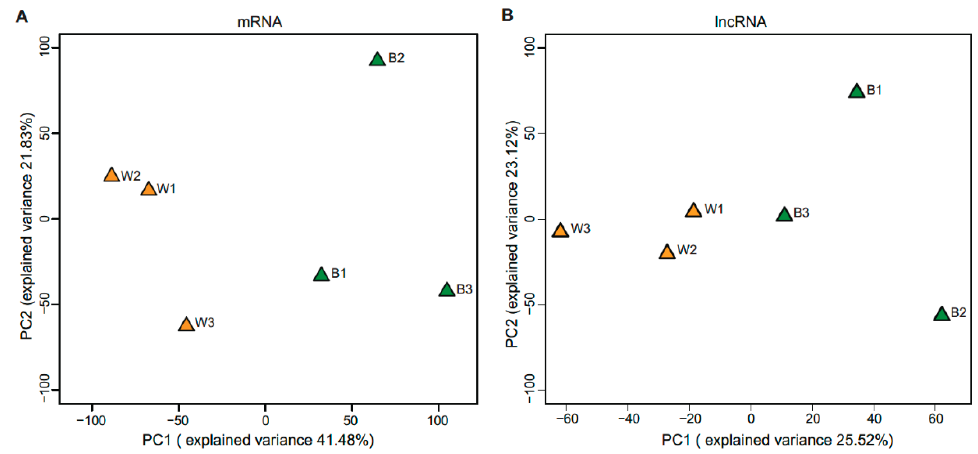
Figure 2. Principal component analysis of mRNA ( A ) and lncRNA ( B ).